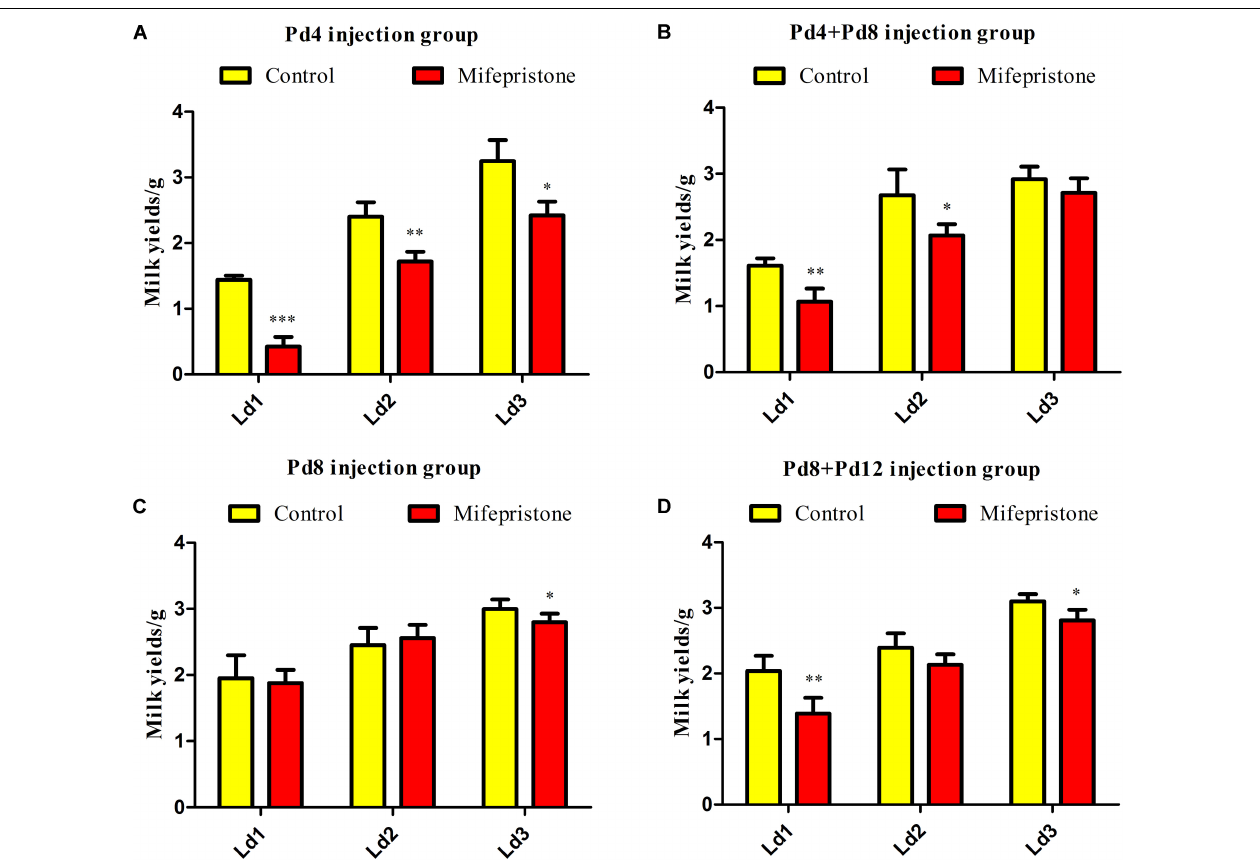
FIGURE 2 | The effect of four different treatments with mifepristone during pregnancy on milk yields. (A–D) illustrated the milk yields from lactation day 1 (Ld1) to Ld3 after performing pregnancy day 4 (Pd4), Pd4 + Pd8, Pd8, and Pd8 + Pd12 strategy, respectively. Data are represented as means ± SD, ∗ indicates the milk yields in mifepristone group are different from that of control group, ∗ P < 0.05, ∗∗ P < 0.01, ∗∗∗ P <